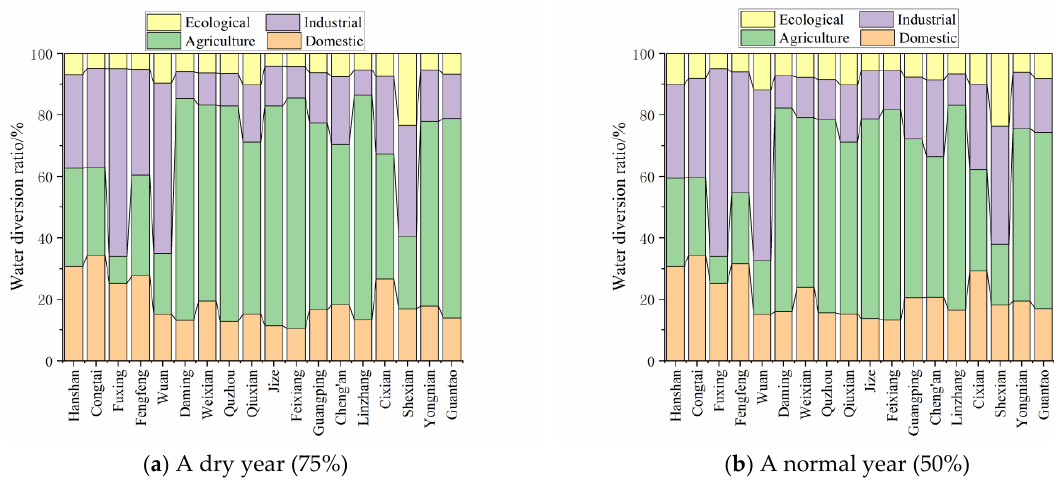
Figure 9. Industrial water distribution in 2025.